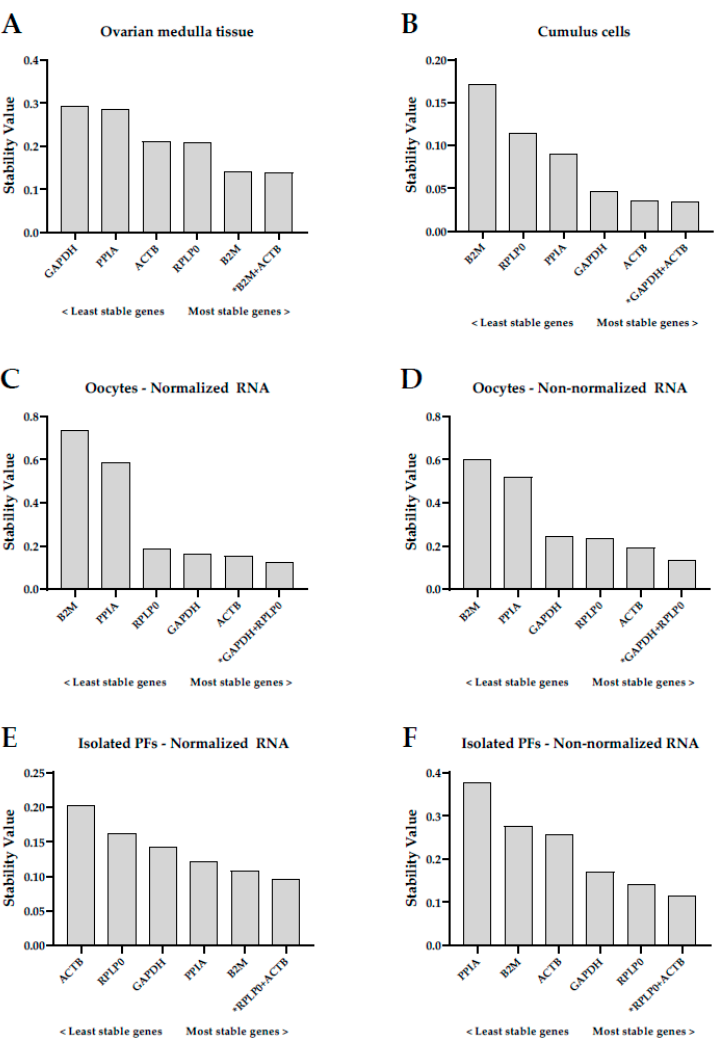
Figure 1. Evaluation of gene expression stability of glyceraldehyde 3-phosphate dehydrogenase (GAPDH), beta-2-microglobulin (B2M), large ribosomal protein P0 (RPLP0), beta-actin (ACTB), and peptidylprolyl isomerase A (PPIA) by the NormFinder software in different human ovarian cells and tissues: ( A ) ovarian medulla tissue; ( B ) cumulus cells; ( C ) oocytes with normalized RNA concentration; ( D ) oocytes with non-normalized RNA concentration; ( E ) isolated preantral follicles (PFs) with normalized RNA concentration; and ( F ) isolated PFs with non-normalized RNA concentration. The genes are ranked from the least ( left ) to the most ( right ) stable. * Best combination of two genes.